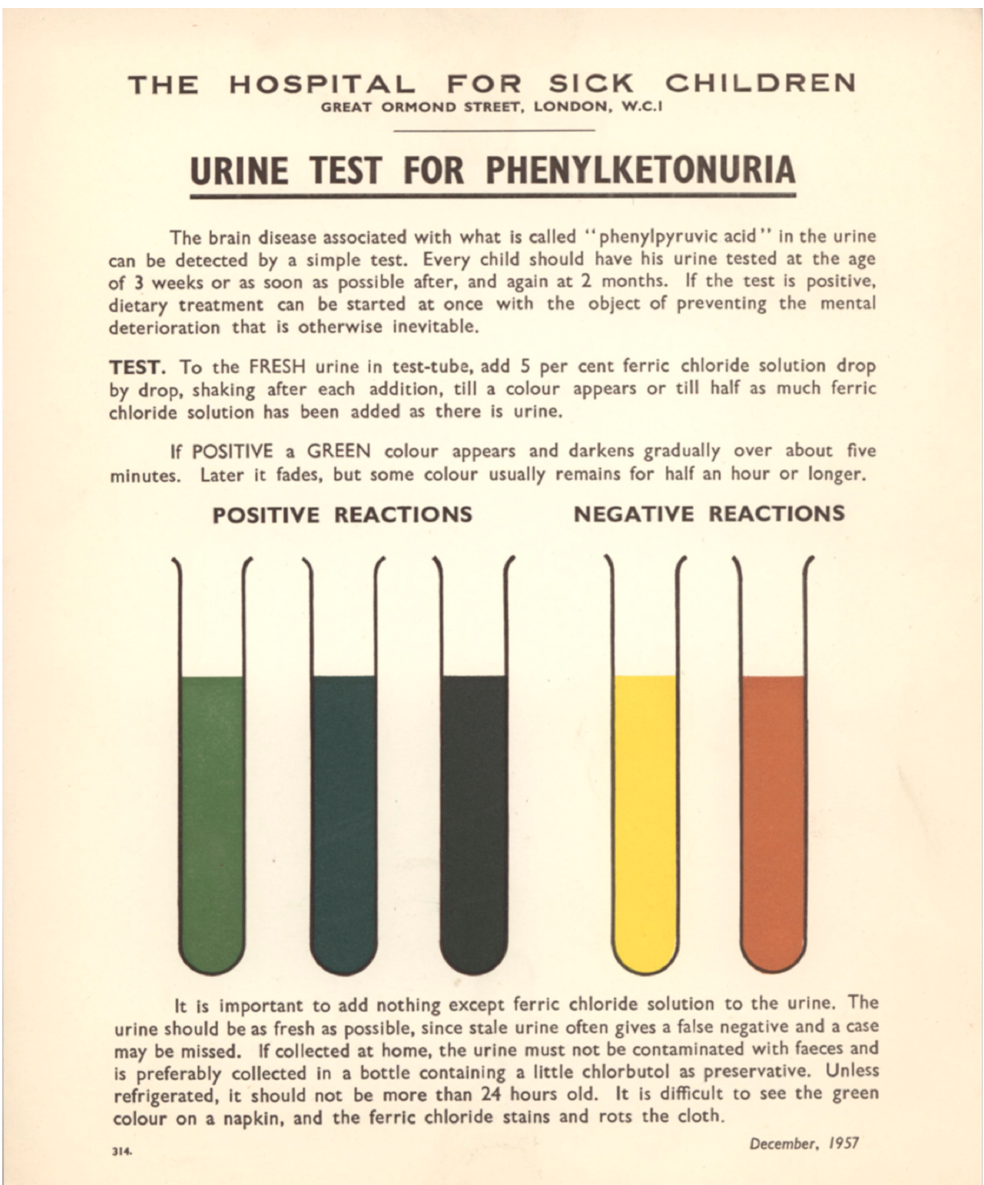
Figure 1. Fact sheet referred to by Woolf et al. in their 1958 article [8]. Thanks are due to the